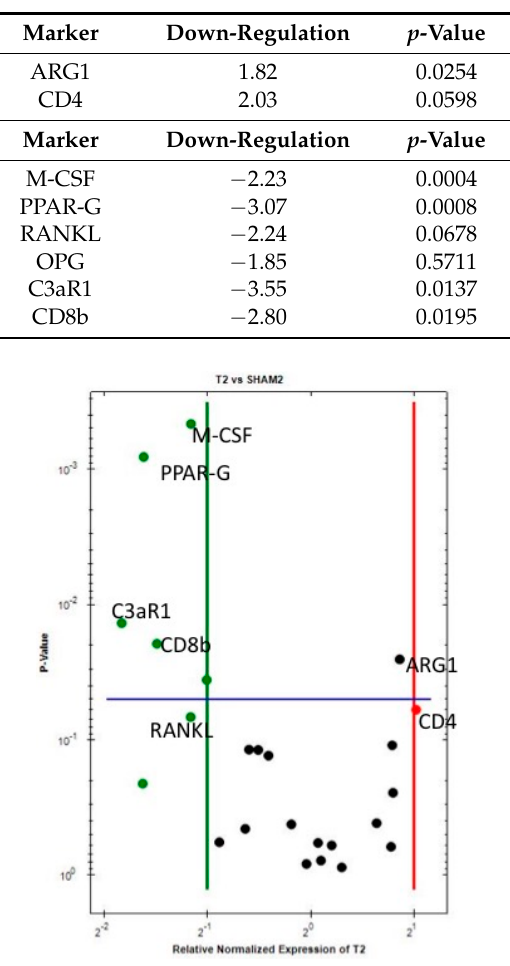
Figure 1. Volcano plot comparing the gene expression of Ti versus Sh at 10 days. Downregulation (vertical green line) and Upregulation (vertical red line) set a × 2 regulation. Statistical significance (horizontal blue line) set at p < 0.05—Marker is significant when above blue line. Table 3. Gene expression Ti vs. Sham.